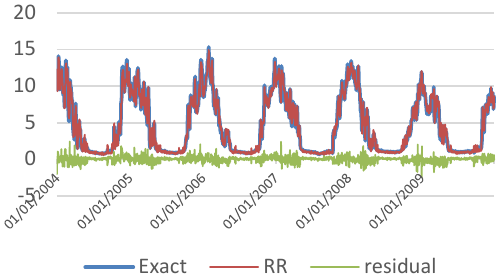
Figure 5. Exact values and RR approximation of natural gas consumption for one-week ahead prediction based on training data